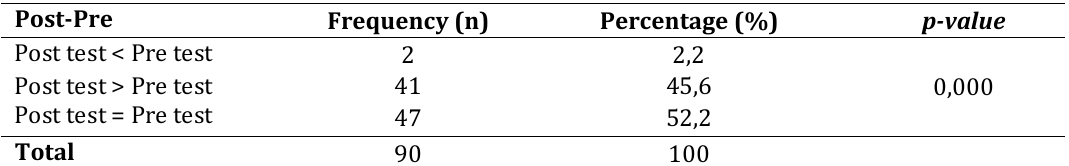
Results of Analysis of the Effects of “Cards in Pairs” Games on Students' Knowledge of Personal Safety Skills to Prevent Sexual Violence at Public Elementary School 2 Serangan in 2018